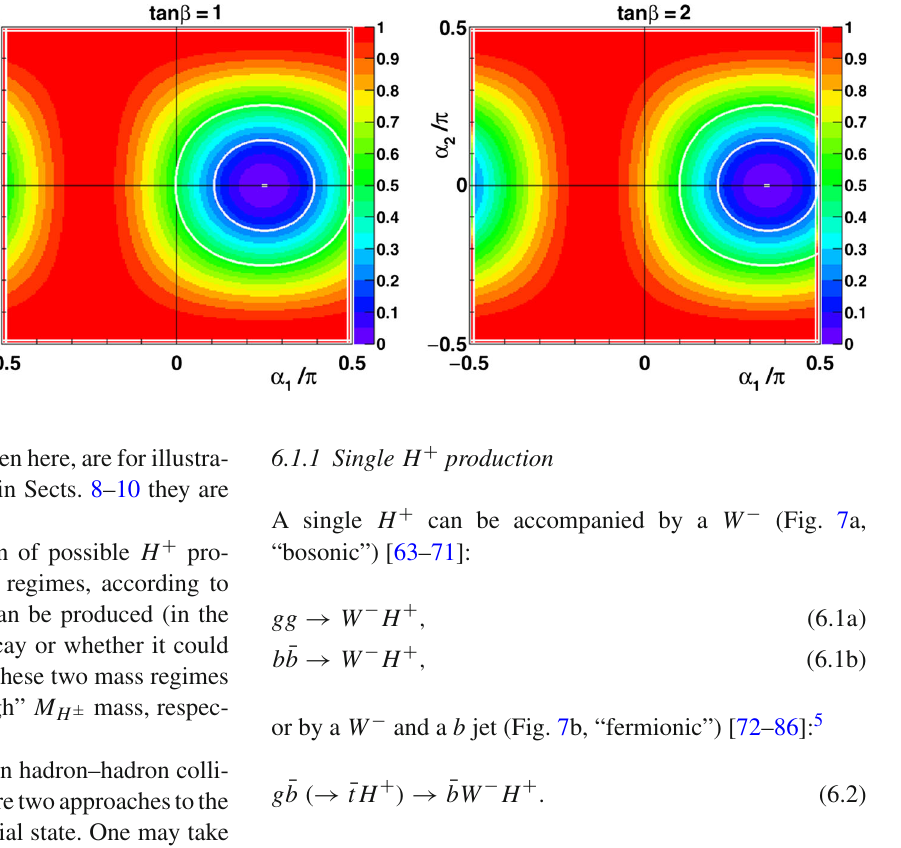
Fig. 6 Relative partial width for H + → H 1 W + , given by Eq. (5.8), vs. α 1 and α 2 , for tan β = 1 and 2. The white “ circles ” outline the region within which the V V H 1 coupling squared deviates by at most 10 or 30% from the SM